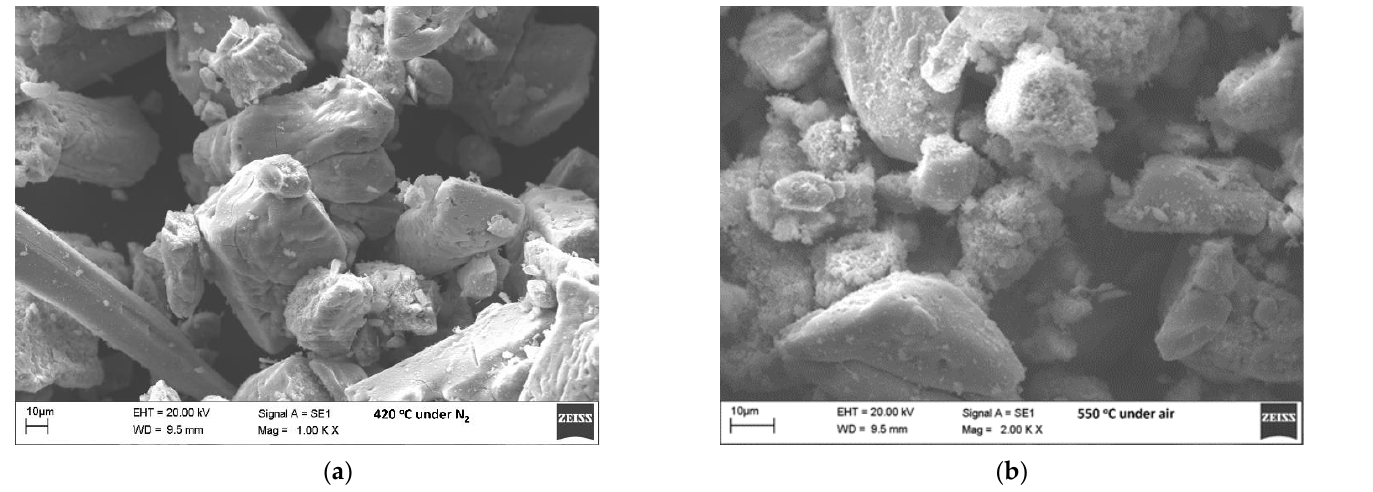
Figure 11. SEM images of the decomposition products formed at 420 °C under nitrogen ( a ) and at 550 °C under air ( b ).